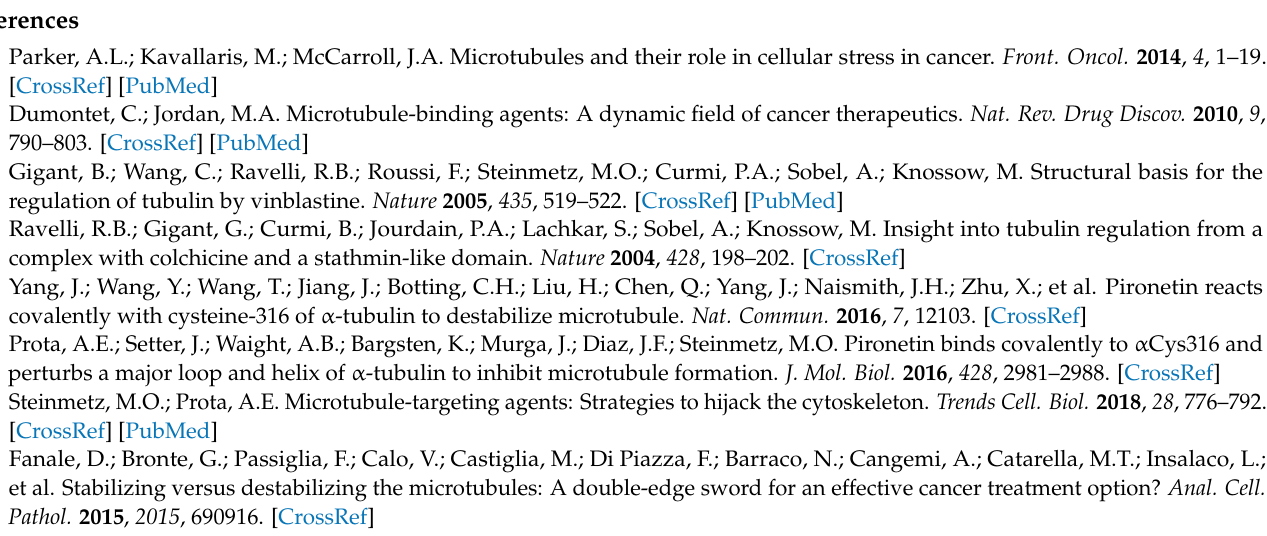
Supplementary Figure S5. Representative images of the HCC1806 xenografts treated with a solvent (control), paclitaxel (PTX), CA-61, and -84. Supplementary Scheme S1: Synthetic pathway of the derivatives of 2-aminopyrrole. Table S1: Characteristics of pyrrole-based compounds and IC50 values in MDA-MB-231 breast cancer cell line. Table S2: Structure-activity relationship (SAR)-based analysis of the features of the molecules in the dataset with observed